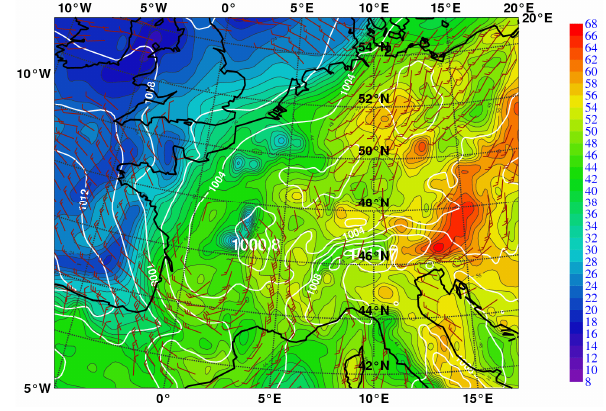
Fig. 1. Equivalent potential temperature (color shading, ◦ C), and horizontal wind (barbs) at the 850hPa pressure level on 26 May 2007, 12:00UTC. White contour lines: mean sea level pressure